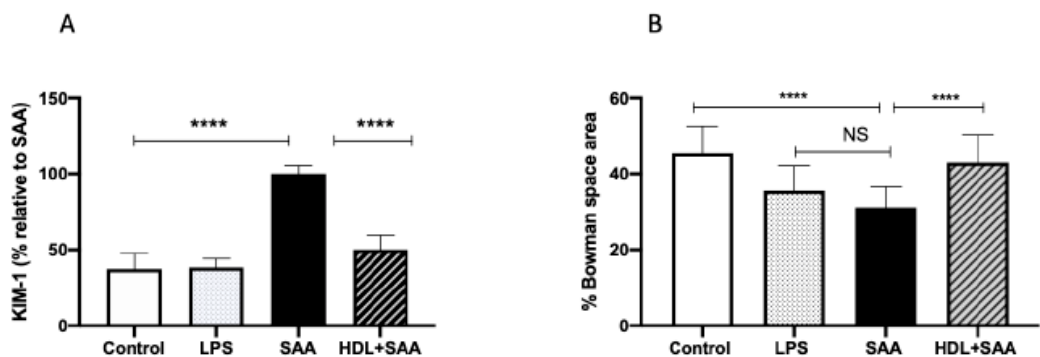
Figure 8. SAA-mediated increase in urinary KIM-1 was prevented by pretreatment with HDL in young mice. Male ApoE − / − mice were allocated into 4 treatments arms and administered with vehicle (control), LPS, SAA alone, or SAA in combination with HDL. ( A ) Urine was collected 4 weeks after commencement of SAA treatment and analyzed for secretory levels of KIM-1, as described in the methods section. Data represent percentage change with respect to SAA levels where mean values were SAA = 592 pg / mL (representing 100%) with mice numbers control ( n = 8), LPS ( n = 8), and SAA ( n = 8), and HDL / SAA ( n = 8). ( B ) Thin kidney sections were stained with H&E, imaged captured, and the relative percentage area of Bowman’s space was determined using n = 30 glomeruli for each isolated kidney from each treatment group, as we described previously [35]. Data represent mean data from glomeruli present in the field of view (3 fields for each section) with mice numbers control ( n = 8), LPS ( n = 8), SAA ( n = 8), and HDL / SAA ( n = 8). * Di ff erent to the control and LPS group, p < 0.05. # Di ff erent to the SAA and HDL / SAA group, p < 0.05. **** p <